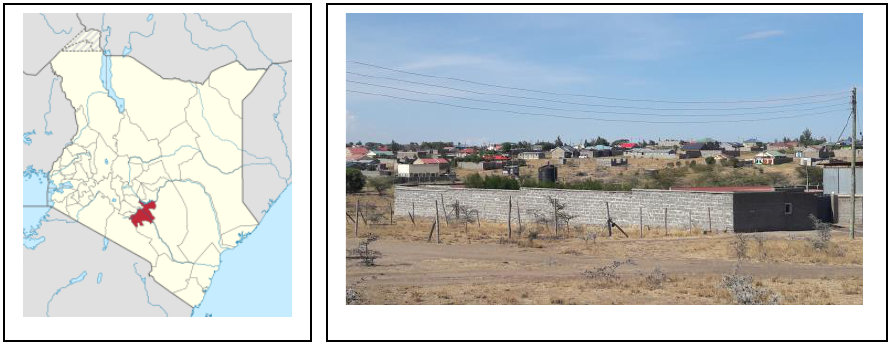
Figure 1: Location of Machakos County and the urbanizing sites in peri-urban areas of Kangundo–Tala Three consumption behaviours related to food security were analyzed. This included: consumption changes, food expenditure reduction and income expansion. A qualitative approach was adopted where a total of 120 newly settled households were sampled and